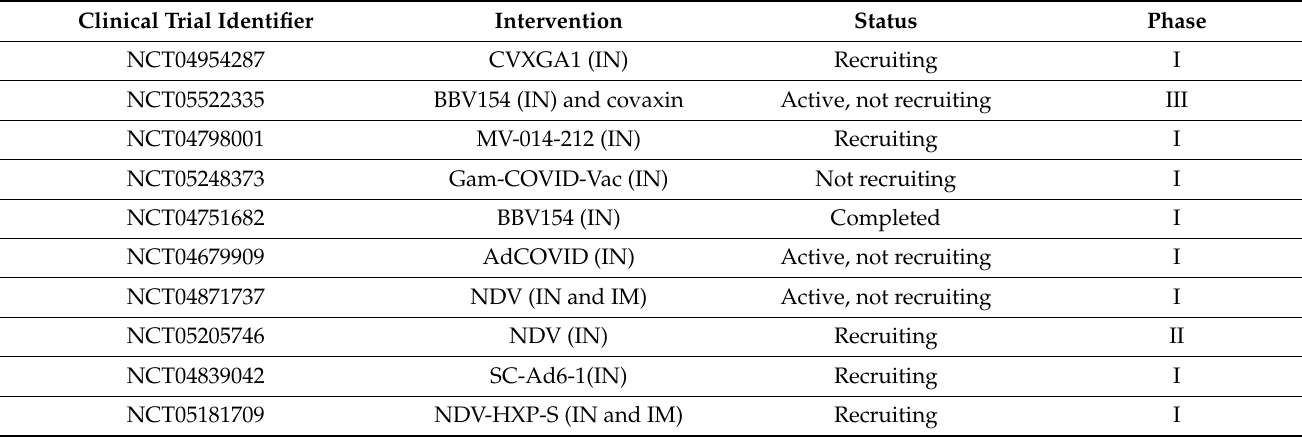
Table 1. Clinical trials underway to evaluate the efficacy and safety of intranasal vaccines or intranasal combined with intramuscular